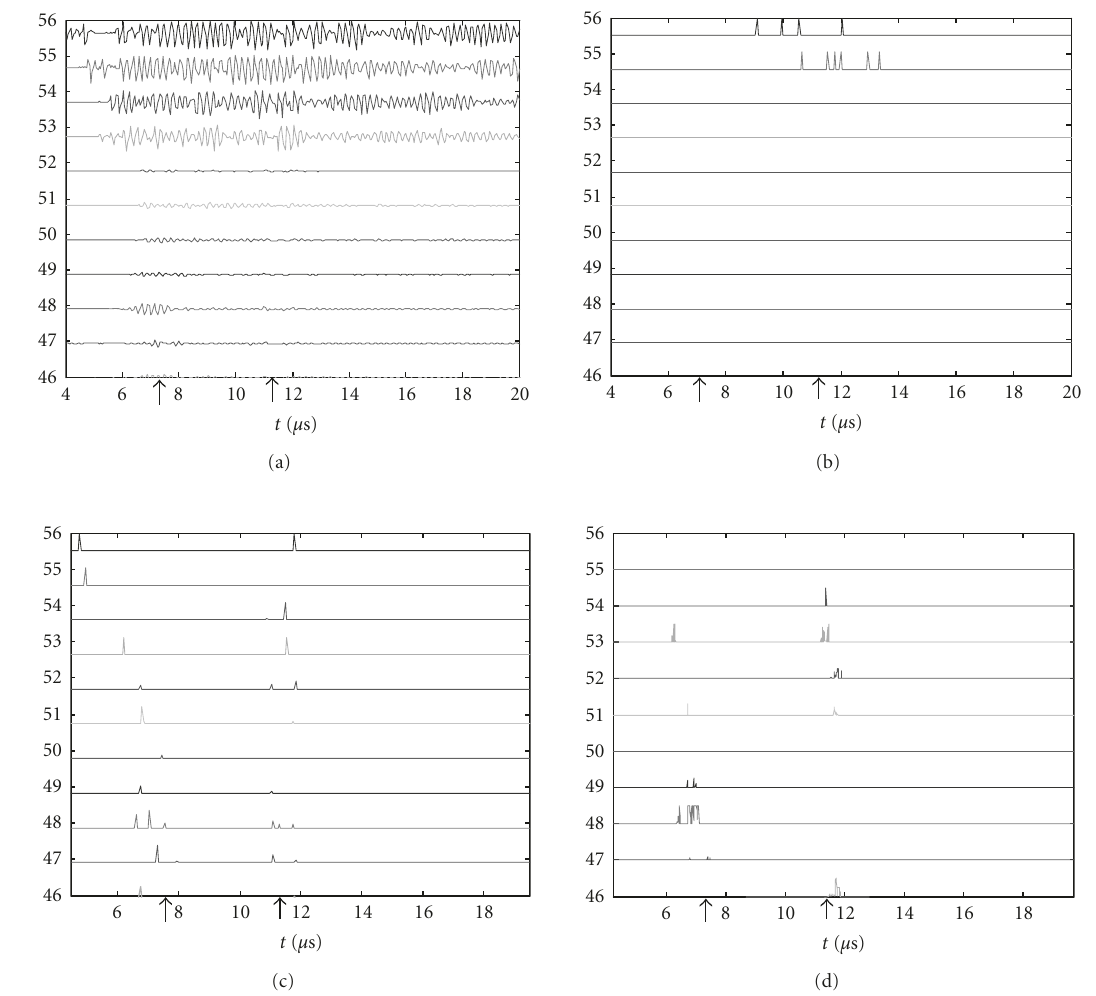
Figure 7: Processed A-scans (46 to 56): (a) original A-scans, (b) matched filter (Model 1), (c) gating of the prewhitened signal, (Model 3), (d) suboptimum